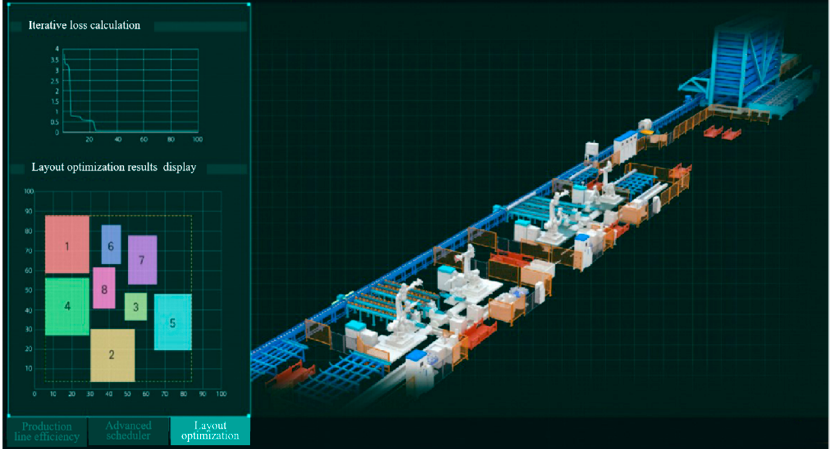
Figure 7. Equipment layout optimization results of pipe machining production line.